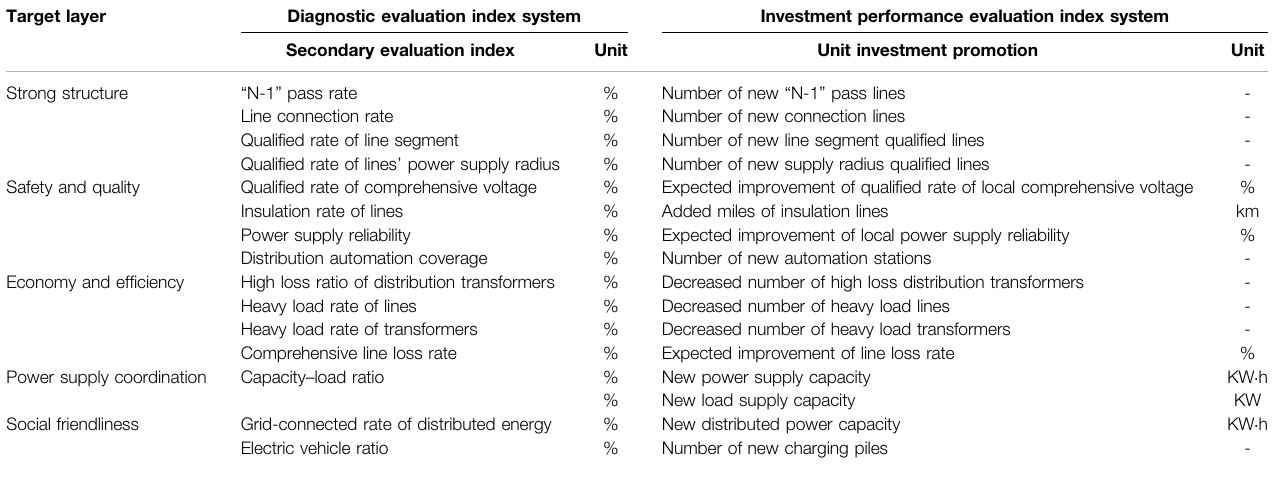
TABLE 1 | Bene fi t index system of distribution network portfolio